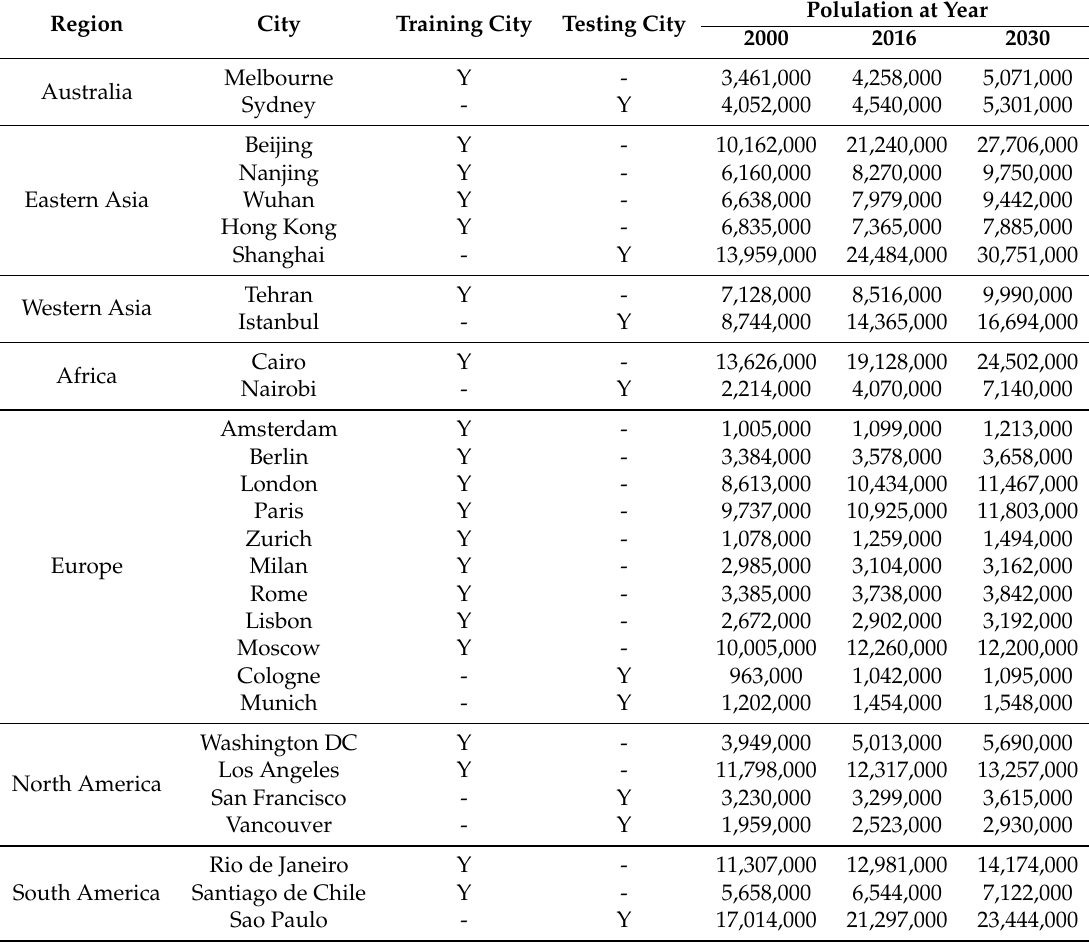
Table 1. List of cities of interest, with information on the regions and populations [34]. List of chosen combinations of cities for training and testing.